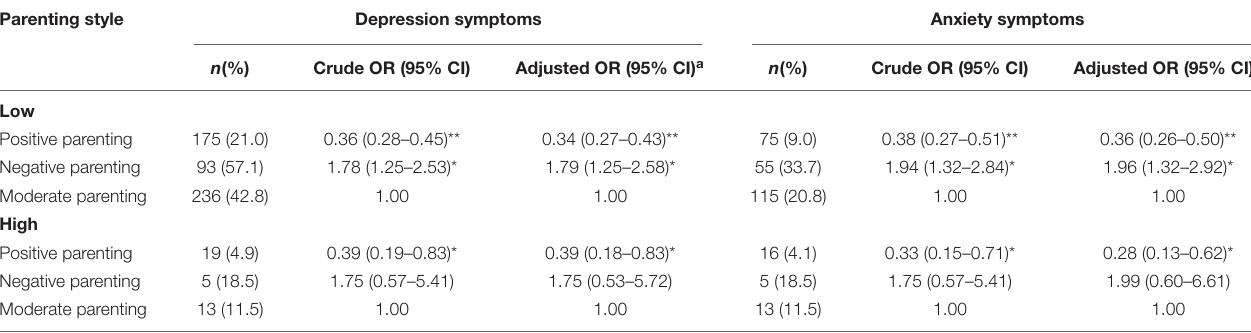
TABLE 4 | Association of parenting style with depression/anxiety symptoms by different level of resilience. Parenting